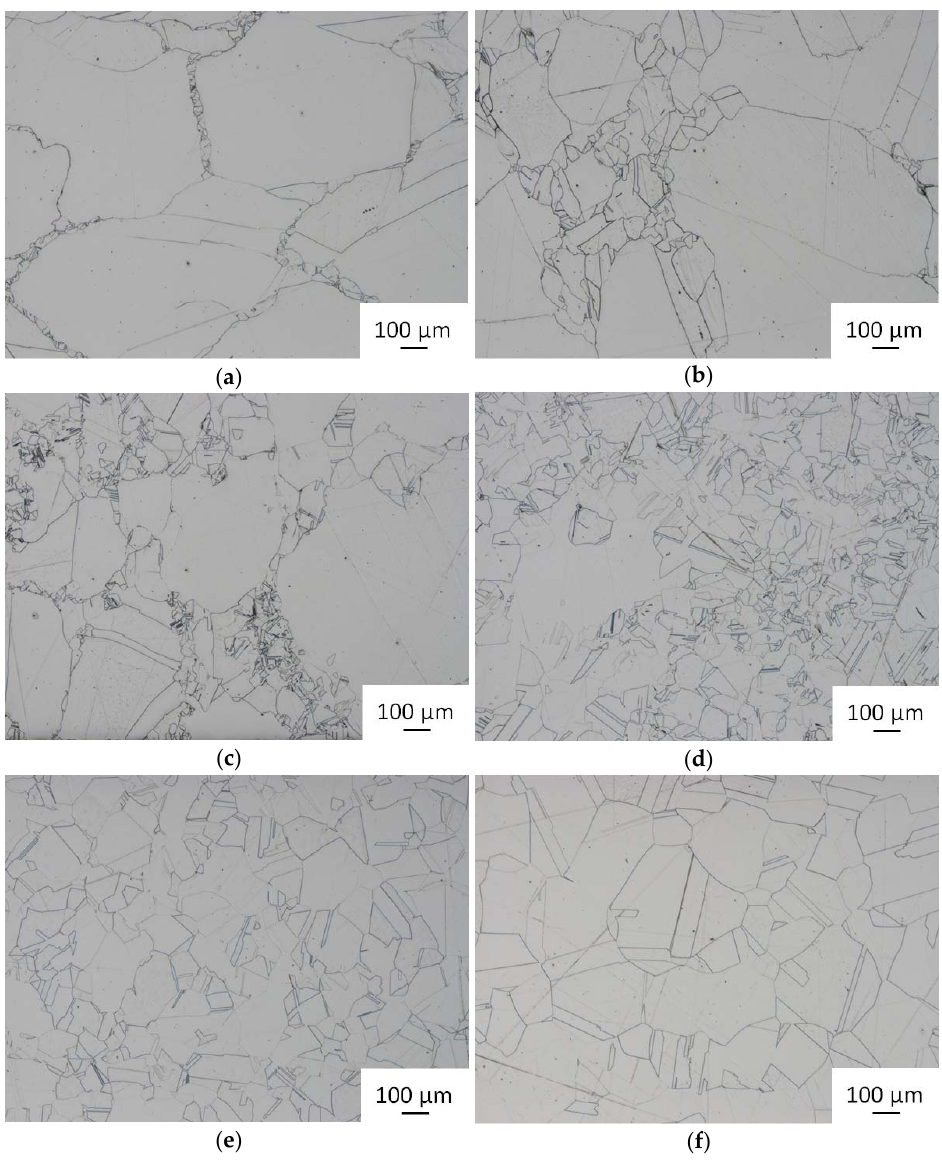
Figure 8. Microstructural evolution in MoNiCr: ( a ) V1—initial as ‐ rolled condition; ( b ) V2—750 °C; ( c ) V3—850 °C; ( d ) V4—950 °C; ( e ) V5—1050 °C; ( f ) V6—1150 °C.